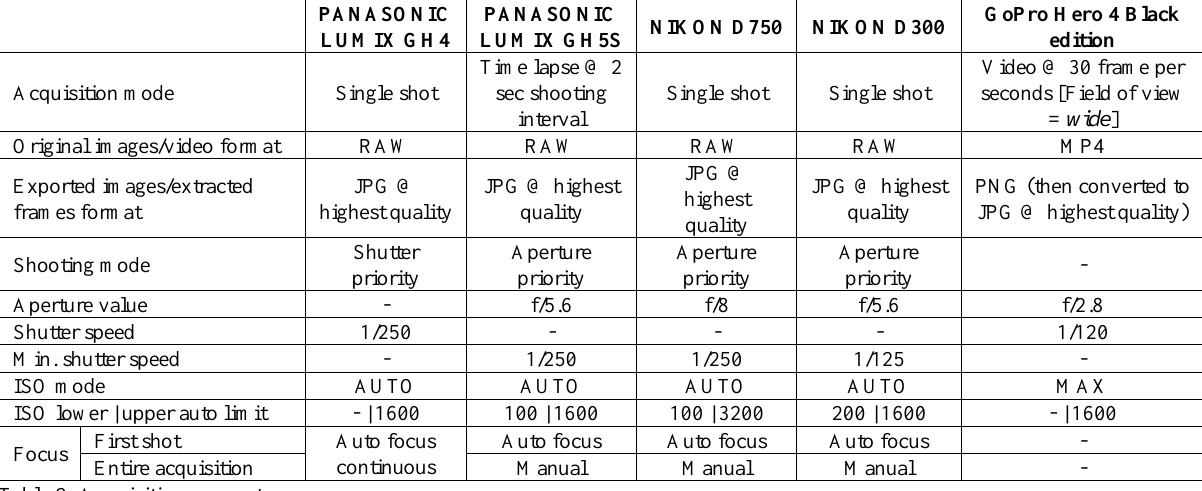
Table 2: Acquisition